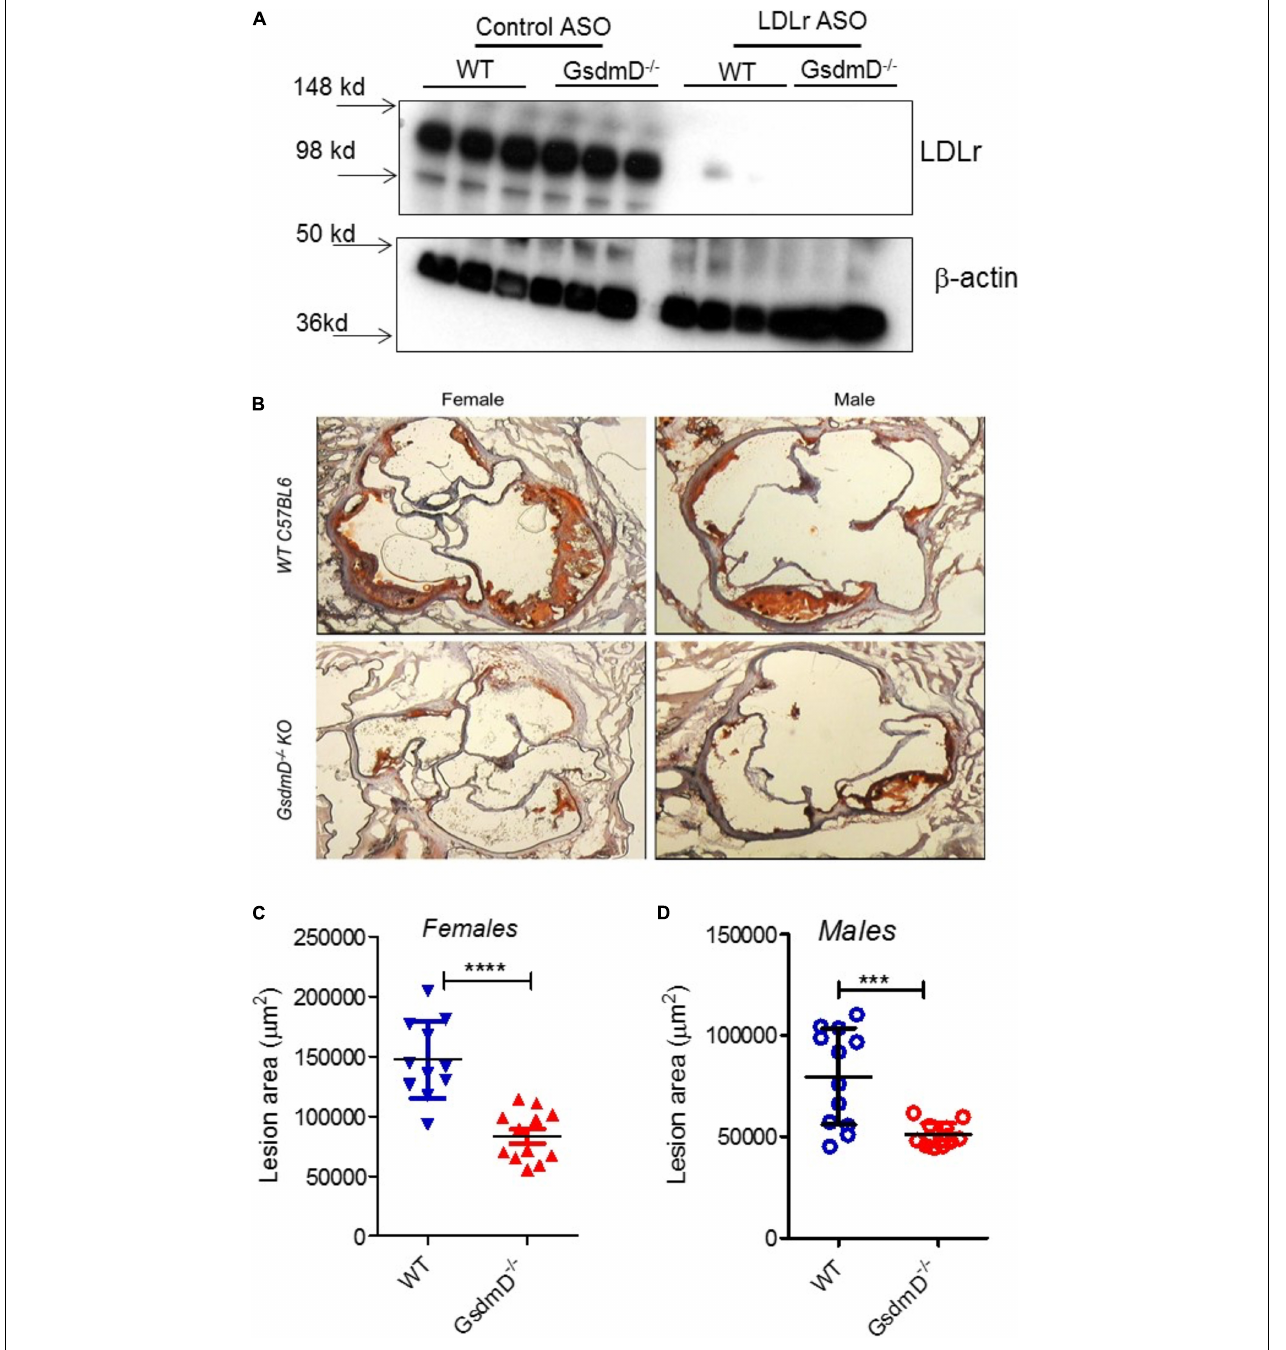
FIGURE 6 | Gasdermin D (GsdmD) promotes atherosclerosis. The 12-weeks old mice from both sexes were injected with either control or LDLr ASO for 9 weeks and were fed western type diet throughout the course of study. Mice were euthanized after 9-week ASO treatment and were perfused with PBS and hearts and livers were removed. (A) A small portion of liver from mice was excised, weighed, and protein extracts were prepared using RIPA buffer supplemented with protease inhibitors. Western blot analysis of LDLr in liver extracts was performed using LDLr antibody and HRP conjugated secondary antibody. (B) Representative images from both sexes showing aortic root lesions stained with Oil red O and hematoxylin from WT or GsdmD - / - KO mice injected with LDLr ASO and fed WTD. (C,D) Quantification of aortic root lesions in females and males from WT or GsdmD - / - KO mice treated with LDLr ASO and fed WTD (for WT male N = 11, for WT females, GsdmD - / - males, and GsdmD - / - females, N = 12, *** p < 0.0005, **** p < 0.0001 by two-tailed t -test).